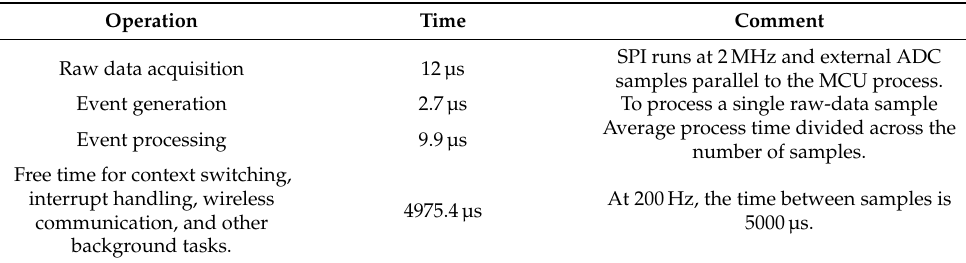
Table 7. Total estimated processing time to run the full algorithm in ARM Cortex-M3 MCU with an external ADC with 200Hz sample rate and 2MHz SPI clock.